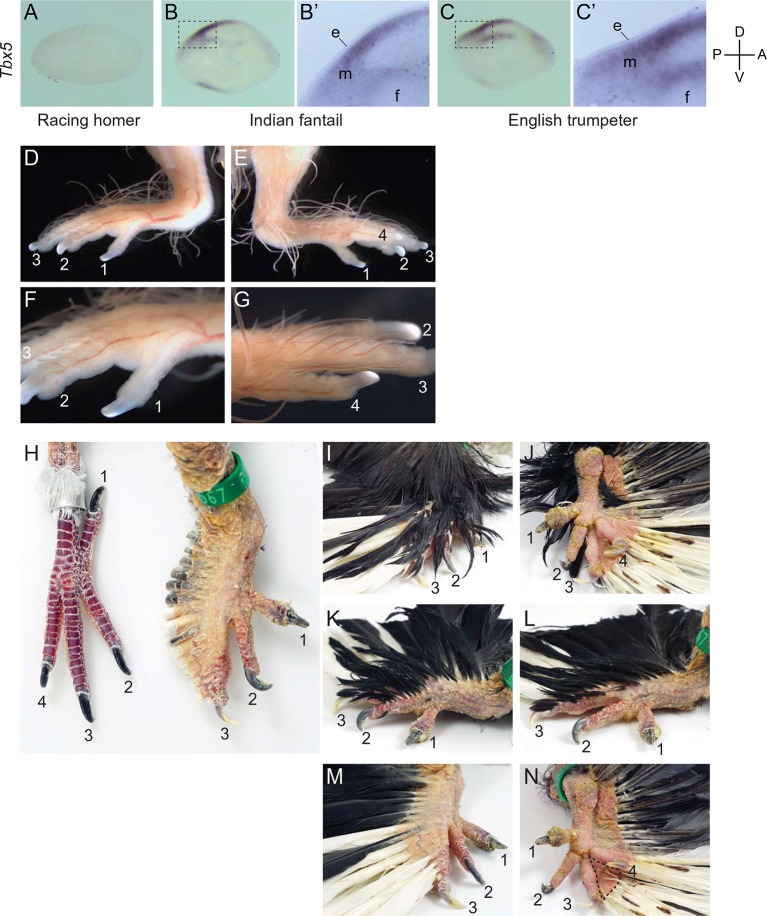
Ectopic hindlimb expression of Tbx5 and epidermal transformations in embryos and adults.(A-C’) Vibrotome sections through HH25 pigeon hindlimbs shown in Figure 3C–E. Tbx5 expression is absent from the hindlimb buds of the wild-type racing homer (A), but is present in the mesenchyme (most notably in the posterior-dorsal region) of the muffed Indian fantail and English trumpeter breeds. Magnified images (B’, C’) show that staining is limited to the mesenchyme (m) and does not extend into the ectoderm (e). Sections were cut in the zeugopod region; magnified sections include the fibula condensation (f). (D-G) Embryonic hindlimb of an English trumpeter at approximately 15 days of incubation. Digits are numbered from medial (1) to lateral (4). Feather primordia are visible as string-like structures throughout the limb in medial (D) and lateral (E) views. Feathers are longer on the lateral digits (G) than on the medial digits, and these differences persist into adulthood. (H) Comparison of adult feet of a racing homer (scaled, wild-type, left) and an English trumpeter (feathered, right). All small feathers have been plucked from the English trumpeter foot, and large feathers have been trimmed down to their insertions in the skin. Note that digit 4 in the English trumpeter is not visible due to the expanded skin on digit 3, and unlike the backward-facing digit 1 of the racing homer, digit 1 faces forward and medially. (I-N) Details of feather size and distribution in the foot of an English trumpeter. Distal ends of long feathers were clipped and therefore full adult feather size is not represented in these images. The toes are barely visible in a dorsal view of an intact foot (I), and the insertion of large feathers on the lateral side of the foot is visible in ventral view (J). Small feathers were plucked from digit 1 and the medial metatarsus to reveal the small feathers inserting on digit 2 in medial view (K), and feathers were plucked from digit 2 to reveal small feathers inserting on dorsal digit 3 and metatarsus (L). Removal of all small feathers shows the lateral insertion points of large feathers on digit 3 in dorsal view (M). Substantial expansion of lateral skin accommodates the insertion of these large feathers, and digit 4 is hidden from view. Similar skin expansion and large feather insertions characterize digit 4 and the lateral metatarsus (N, ventral view). Soft tissue webbing joins digits 3 and 4 (dashed line), as described by Darwin, 1868.